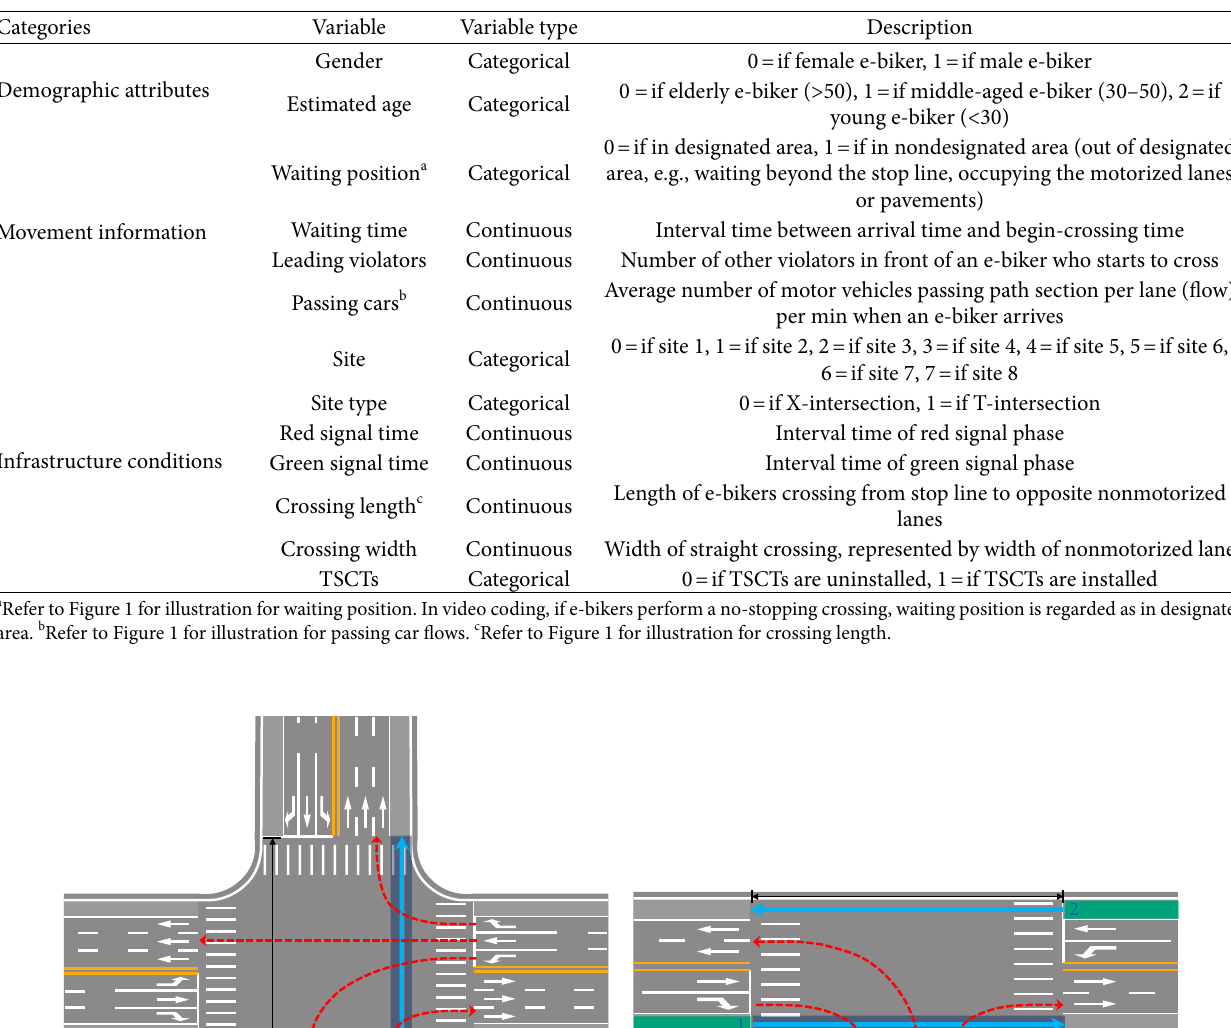
Table 1: Definitions of independent variables.